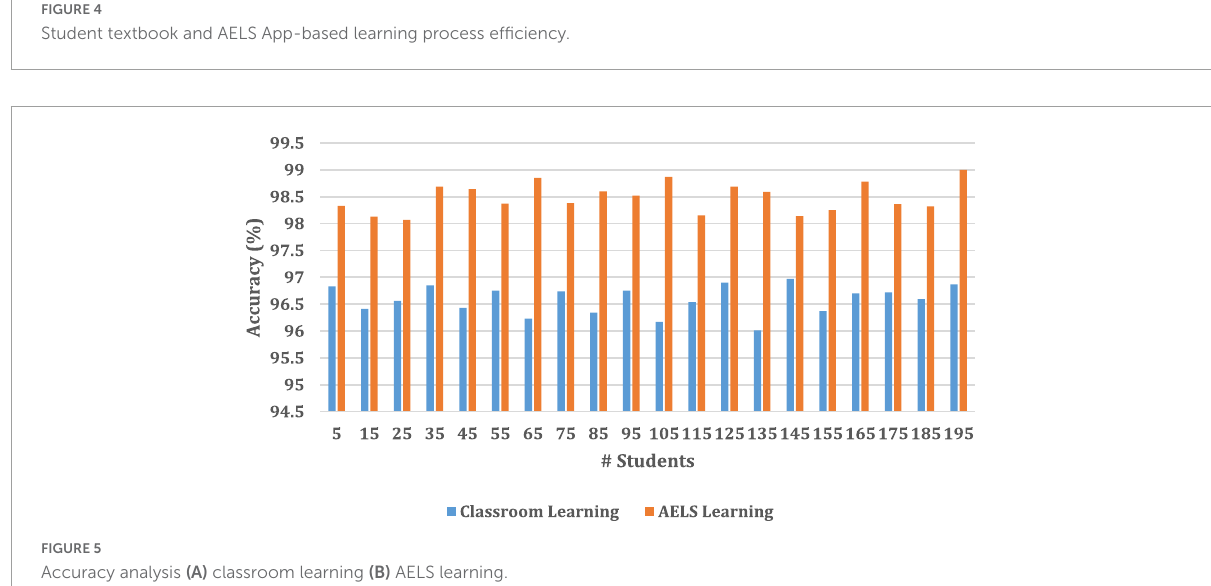
FIGURE5 Accuracy analysis (A) classroom learning (B) AELS